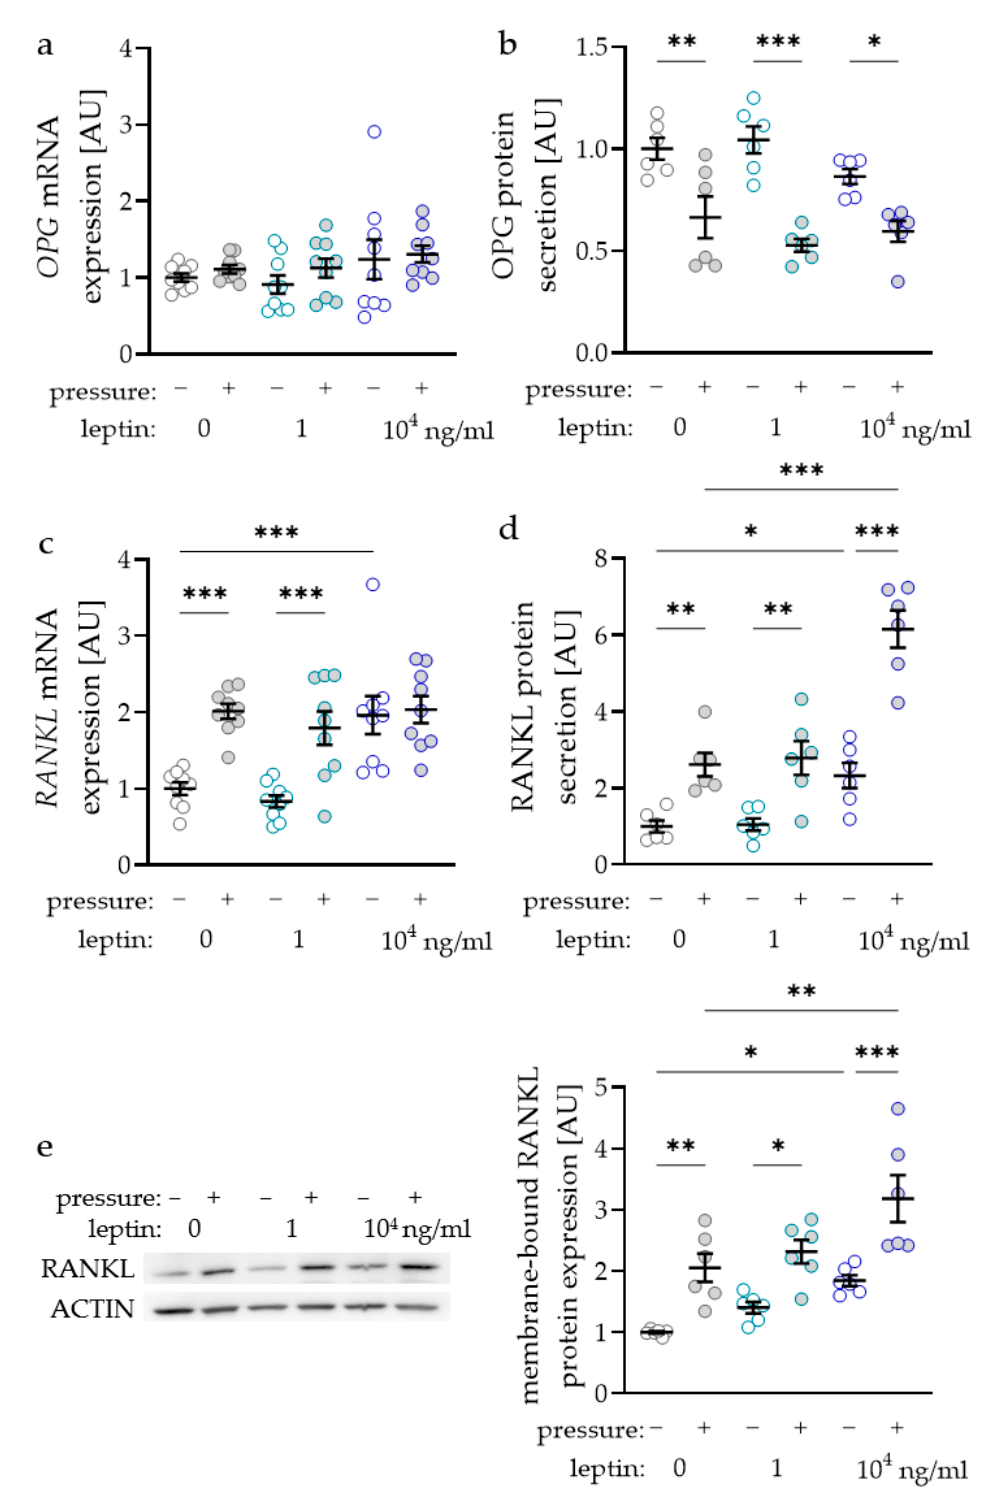
Figure 3. Impact of leptin in combination with compressive strain on gene and protein secretion of osteoprotegerin (OPG; a , b ) and on gene and protein secretion respectively expression of membrane bound receptor activator of NF-kB ligand (RANKL; c – e ) in PDLF; n ≥ 6; Statistics: ordinary ANOVA with Holm–Sidak’s multiple comparison tests; OPG mRNA: Welch-corrected ANOVA with Games– Howell’s multiple comparison tests; * p < 0.05, ** p < 0.01, *** p < 0.001.